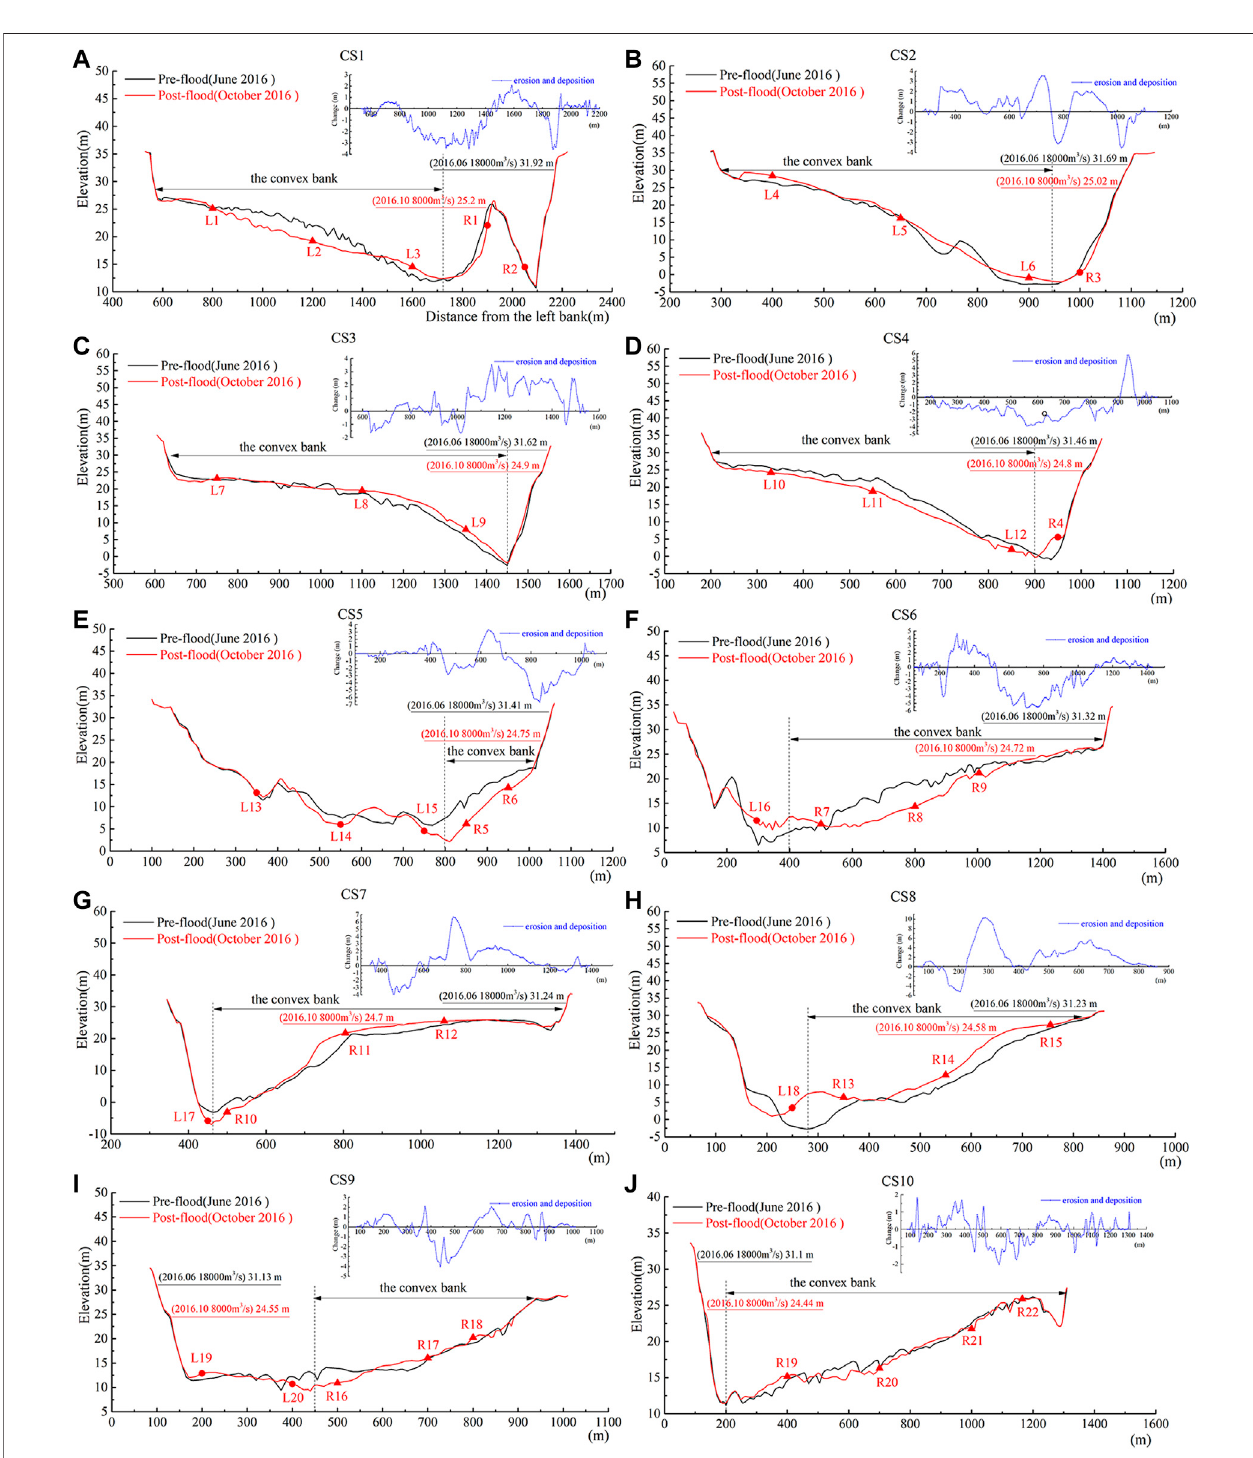
FIGURE 9 | Morphological changes of ten surveyed transects (A-J) in the Bend A and Bend B during fl ood season. These observation points (42) are laid on the convex bank, thalweg, and concave bank to monitor the bed material composition, the near-bed velocity, and thestreampower ( Tables3 , 4 ).Thetriangular points (30) represent the observation points located on the shallow, middle, and deep shoals of the convex bank, and the red dots (12) represent the observation points on the thalweg and on the concave bank.